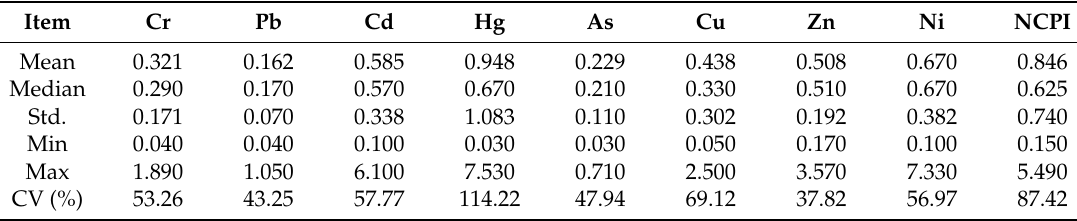
Table 6. Descriptive statistics of SPIs and NCPIs (mg/kg, N =